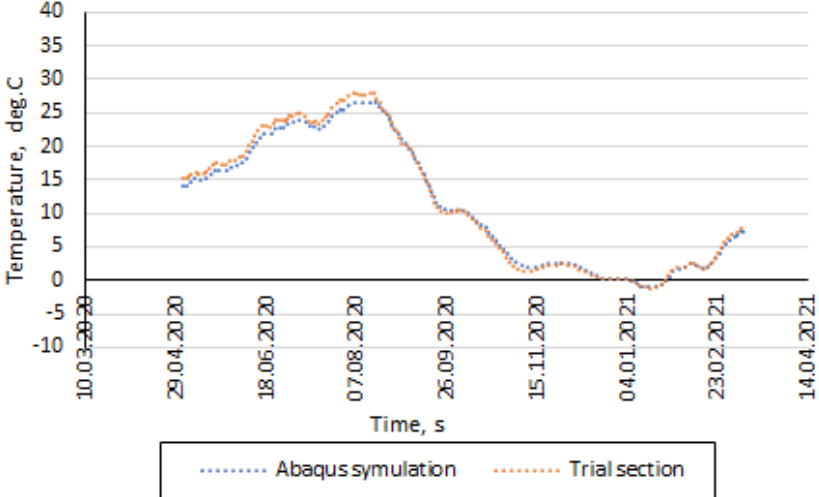
Figure 7. Temperature distribution at the interface between the SMA-JENA and CRM-FB_5C layers, recorded by the P2 sensor, after data smoothing.